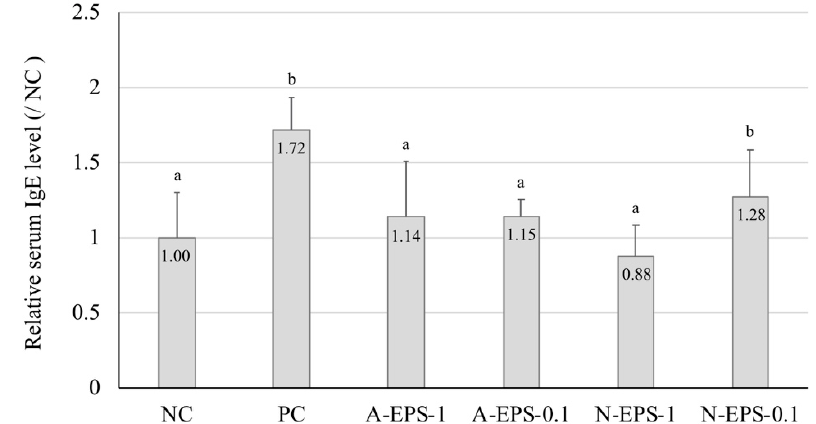
Figure 3. E ff ect of oral administration of IJH-SONE68-derived neutral and acidic EPSs on the serum IgE concentration at 24 h after the challenge. Abbreviations used in the figure: NC, negative control (without inflammation); PC, positive control (without treatment); A-EPS-1, acidic EPS (1 mg / mL); Di ff erent characters described on the top of the bars indicate statistically significant di ff erences between means of values obtained in di ff erent group (the Tukey–Kramer test, p <